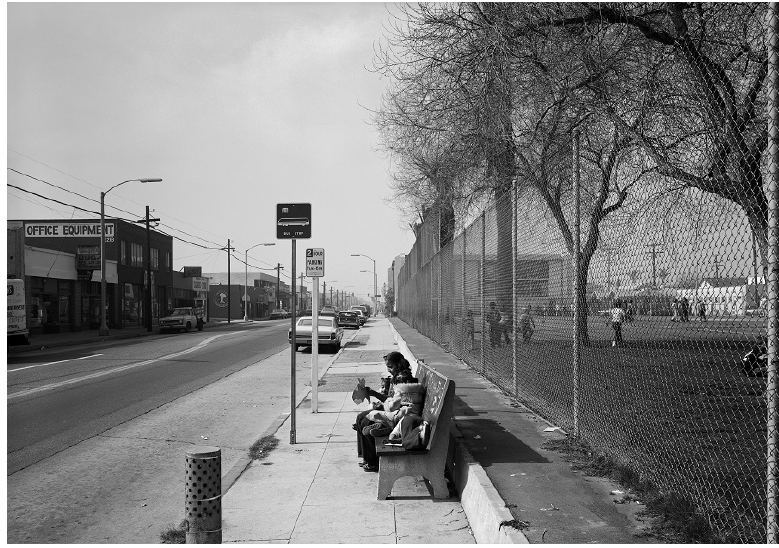
Figure 14. Anthony Hernandez, Public Transit Areas #3 (1979), © Anthony Hernandez.